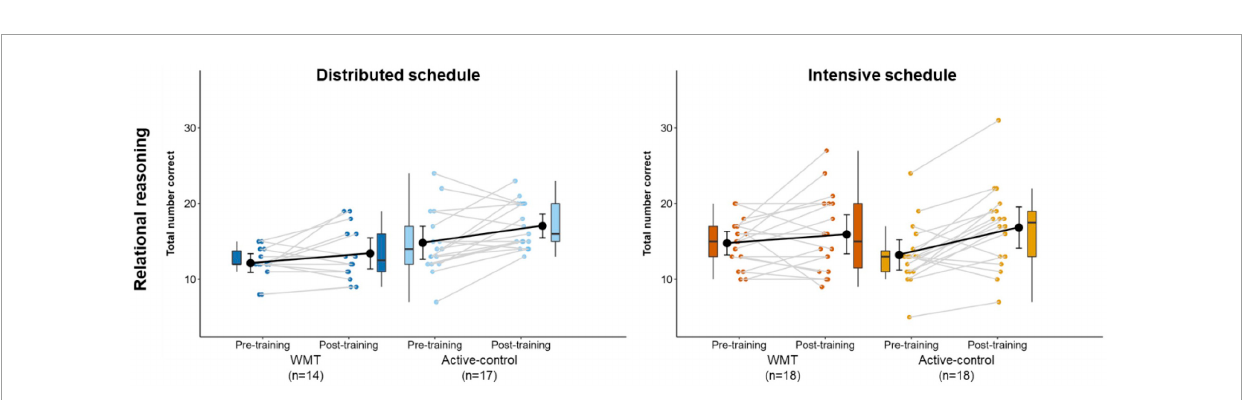
FIGURE7 Performance on the relational reasoning task at pre-training and post-training, separately for distributed groups (left) and intensive groups (right) . Box plots represent the median (crossbars), 1st and 3rd quartile (upper and lower hinges, respectively), and the range of the data (whiskers). Single data points represent individual participants. Black circles and error bars show the group mean and 95% confidence